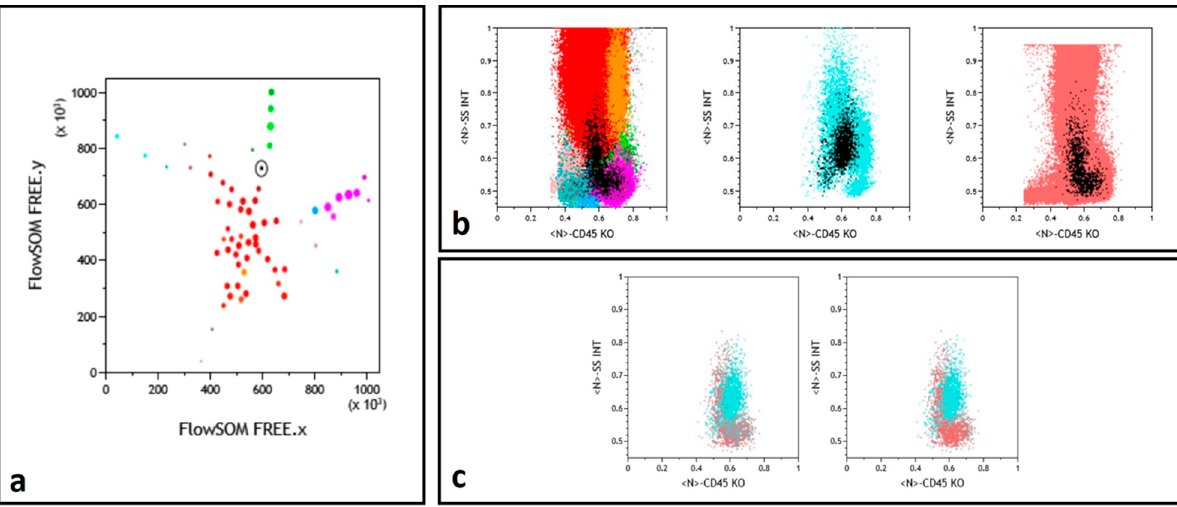
Figure 3. Myelomonocytic regeneration. ( a ) Position of a selected node (round black gate) on the FREE NBM representation, between immature granulocytes (dark red) and monocytes (green). Color codes from ref. [13,15]. ( b ) Backgating (black dots) of this node identifying a regeneration pattern similar in NBM (left) and FU (right) samples and a different population in the middle Dg histogram. ( c ) Selected node CD45/SSC representation with superimposition of the NBM (gray) and FU (powder pink) events while Dg sample (cyan) events are differently backgated.